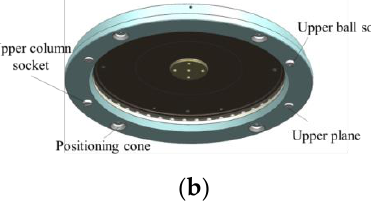
Figure 8. ( a ) The up view of the three-dimensional model of multi-station switching device. ( b )The bottom view of the three-dimensional model of multi-station switching device.